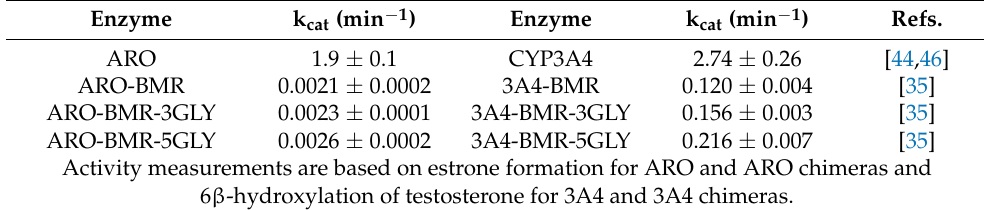
Table 1. Effect of BMR fusion on aromatase and P450 3A4